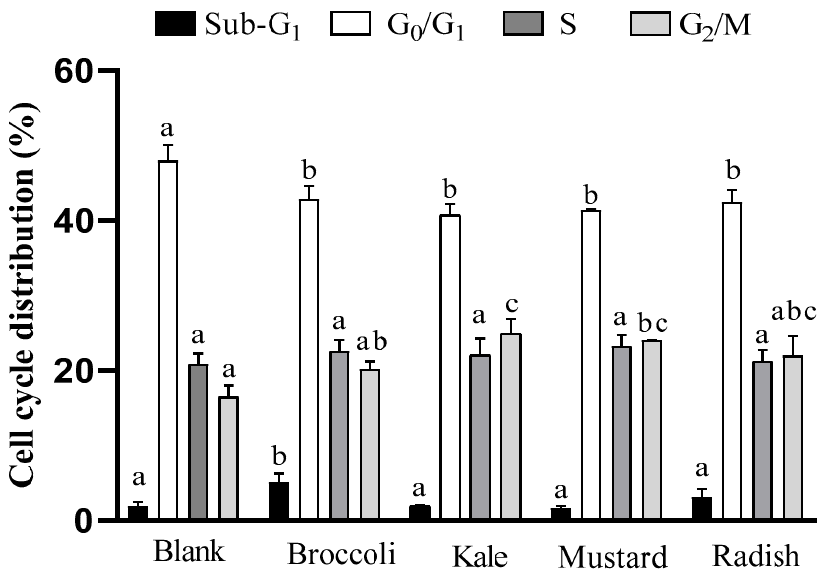
Figure 1. Evaluation of cell cycle distribution after incubation for 24h with bioaccessible fractions obtained from Brassicaceae microgreens (diluted 1:10 v / v in DMEM) in Caco-2 cells. Results are expressed as mean ± standard deviation (n = 4) in two independent assays. Di ff erent lowercase letters (a–c) indicate statistically significant di ff erences ( p < 0.05) among samples within the same cellular phase. Positive control (5-FU) increased 8-fold proportion of cells in sub-G 1, with a concomitant decrease in the rest of phases (G 0 / G 1 , S and G 2 / M) vs. control (untreated cells).